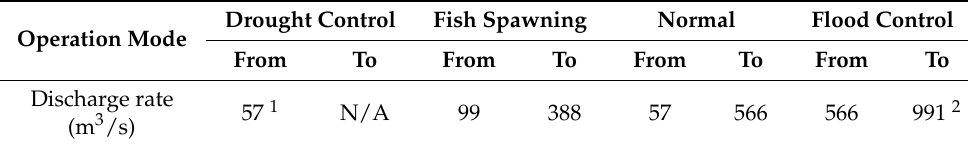
Table 3. Dam operational modes and range of flow rates [modified from Dominion [27]]. Drought Control Fish Spawning Normal Flood Control Operation Mode From From To From To From To